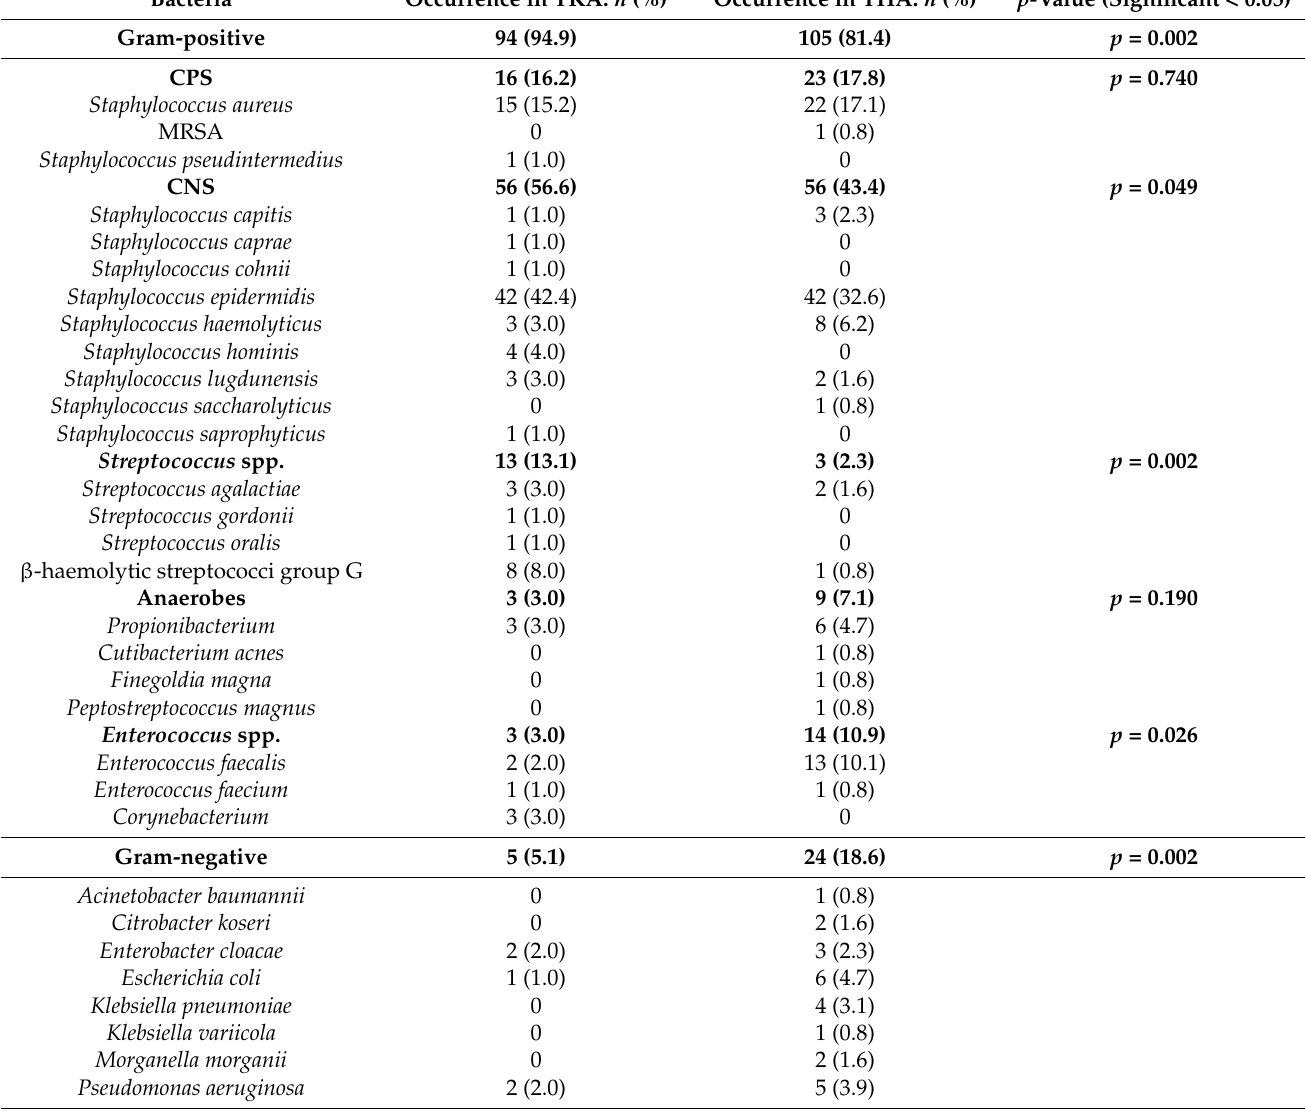
Table 1. List of bacteria identified in the